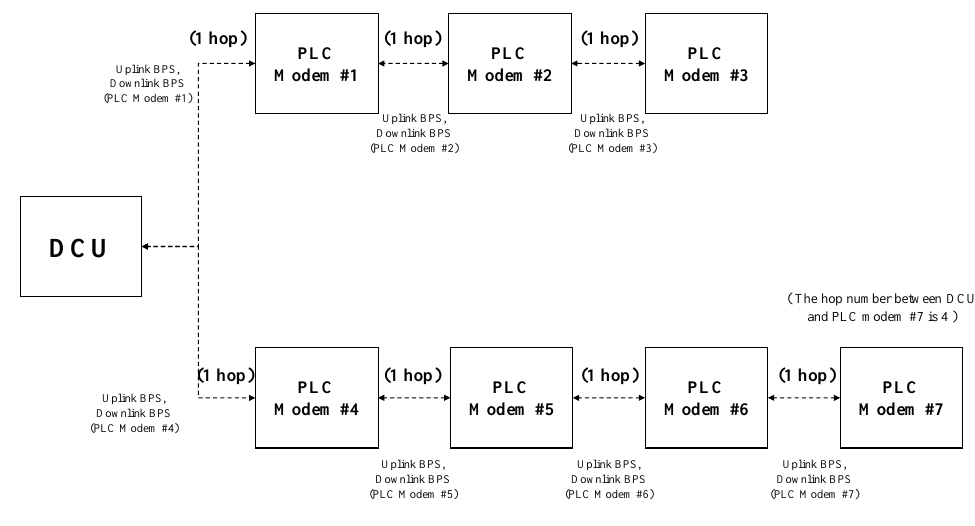
Figure 2. Configuration example of AMI field network in